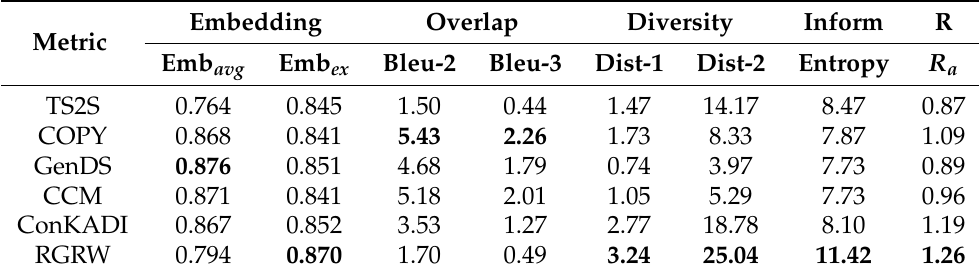
Table 4. The empirical comparison of RGRW against its baselines. Scores in bold stand for the leadership among the response